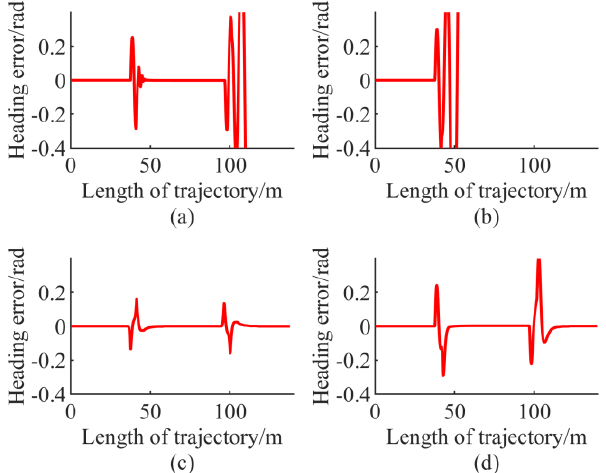
Table 4. The maximum absolute values when velocity is 4 m/s.